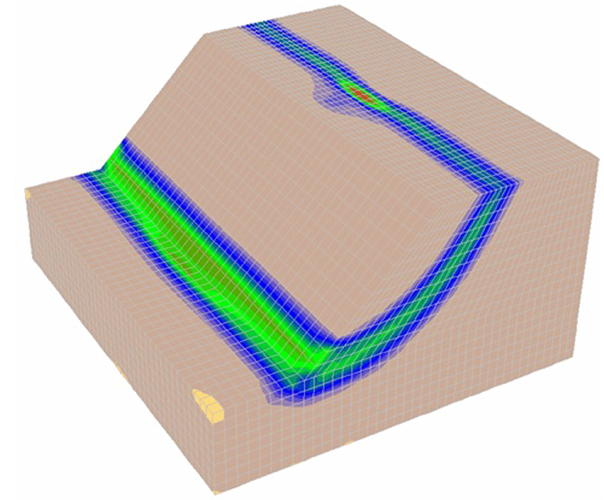
Figure 5. Failure mechanism for L/B = 1.0 by SRM (shear strain distribution).